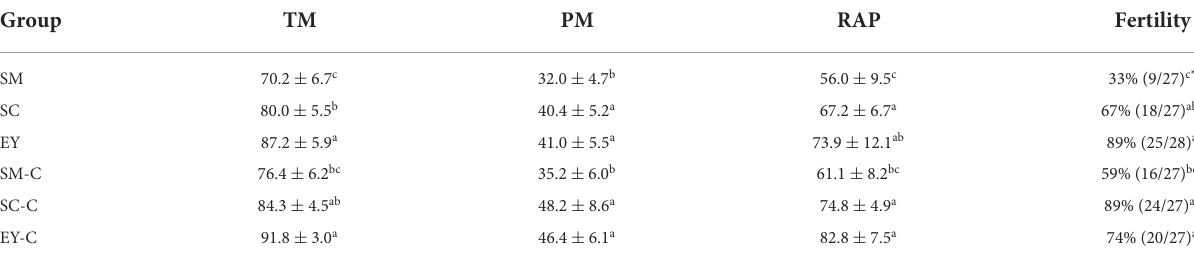
TABLE 2 Sperm parameters and fertility rates of donkey semen centrifuged (C) or not and extended in skimmed milk (SM), sodium caseinate (SC) or egg yolk (EY)-based extender and cooled for 24h. Group TM PM RAP